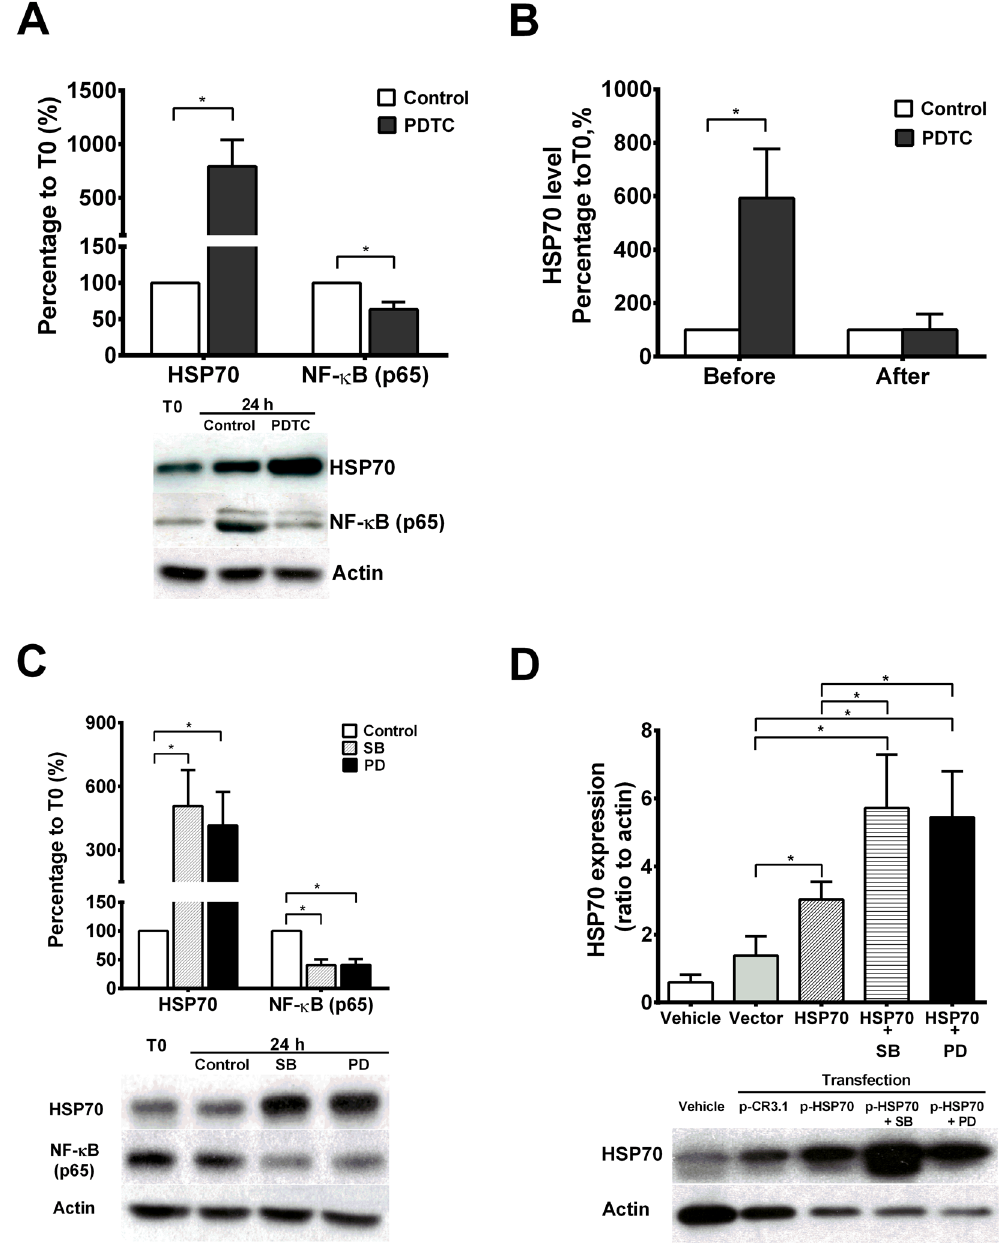
Figure 3. ( A ) Levels of HSP70 and NF-kB p65 in alveolar macrophages of TB patients (n = 6) quantified by western blot analysis in the absence or presence of a NF-kB inhibitor (PDTC). * p < 0.05 compared with control. ( B ) HSP70 levels in AM from TB patients (n = 4) quantified by western blot analysis in the absence or presence of a NF-kB inhibitor (PDTC) before or after anti-TB treatment for 3 M. * p < 0.05 compared with control. ( C ) Western blot analysis to quantify the expression of HSP70 and NF- κ B p65 in AM from TB patients (n = 7) in the absence or presence of a p38 kinase (SB) or ERK kinase inhibitor (PD). * p < 0.05 compared with control. ( D ) Levels of HSP70 in HSP70 overexpressed AM (HSP70) from TB patients (n = 5) in the absence or presence of a p38 kinase (SB) or ERK kinase inhibitor (PD). * p < 0.05 compared with vector transfection control